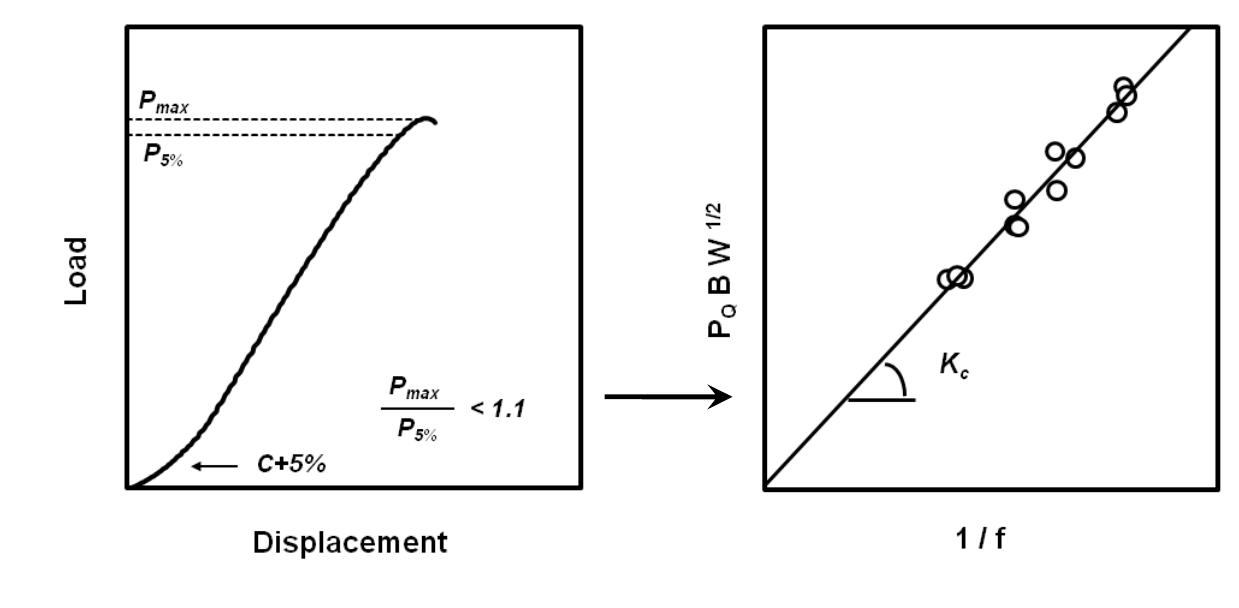
Figure 10. Determination of the critical stress intensity ratio, K load-displacement curves.